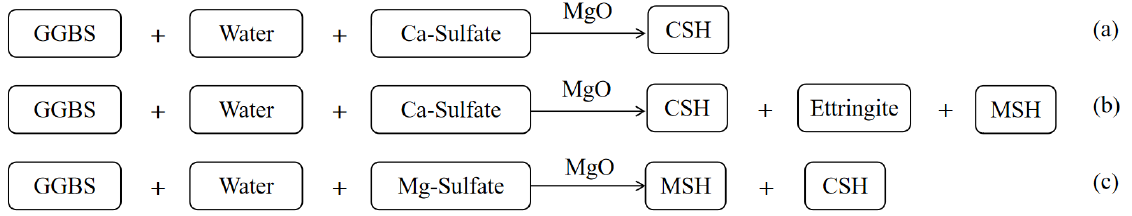
Figure 11. Schematic of mechanism for ( a ) and ( b ) GGBS-MgO-treated Ca-sulfate-soils, ( c ) GGBS- MgO-treated